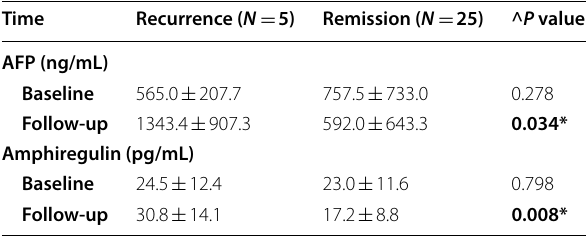
Table 8 Comparison according to tumor recurrence